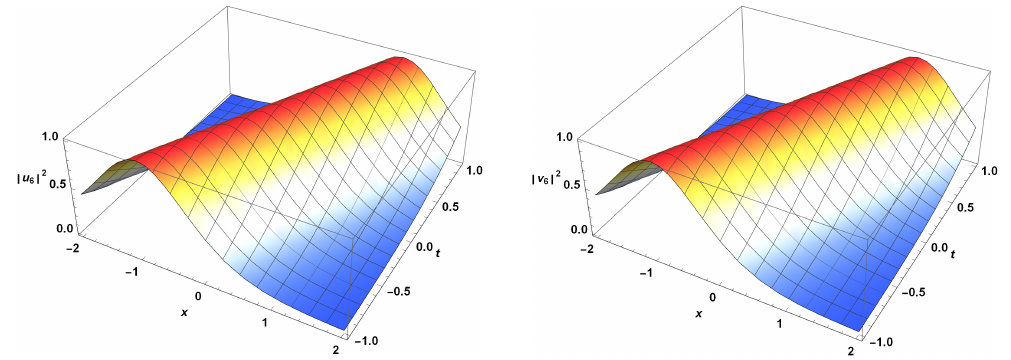
Figure 2. Surface plots of bright magneto-optic solitons (41) with e 1 = k 1 = λ 1 = θ 1 = κ = n = d 1 = ξ 0 = c = ω = θ 0 = τ 3 = 1, a 1 = − 1, h 1 = τ 2 = (cid:118) = 2 and τ 1 =